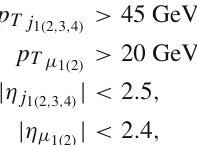
Fig. 3 Cross sections of the Drell–Yan processes in Fig. 2 as function ofthelightermass m B atthe14-TeVLHCwith g ∗ = to the total cross section of the SM background about 1 . 13 × 10 7 fb